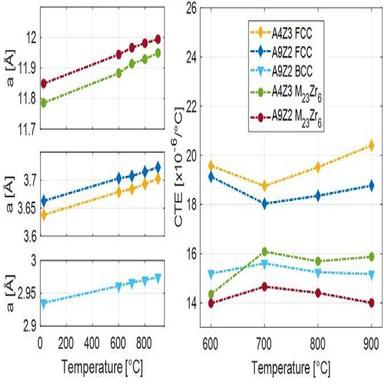
Left side: lattice parameter evolution from RT to 900 °C for FCC and M23Zr6 for A4Z3 and for FCC, BCC and M23Zr6 for A9Z2. Right side: change of CTE based on the lattice parameter evolution of the different phases and temperatures. For colors, please see digital version.